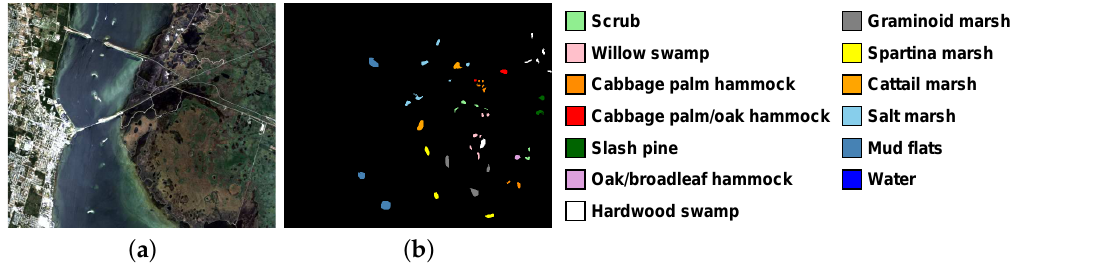
Figure 4. AVIRIS Kennedy Space Center dataset. ( a ) RGB composite image of three bands. ( b ) Ground-truth map.